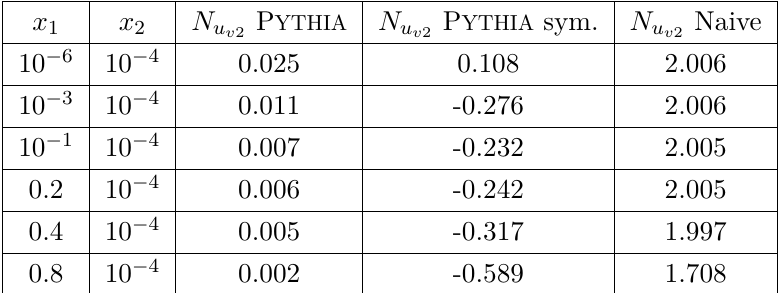
Table 12 . Same as in table 9 but for the symmetrized R ∗ situation when the GS sum rules are perfectly satisfied N u